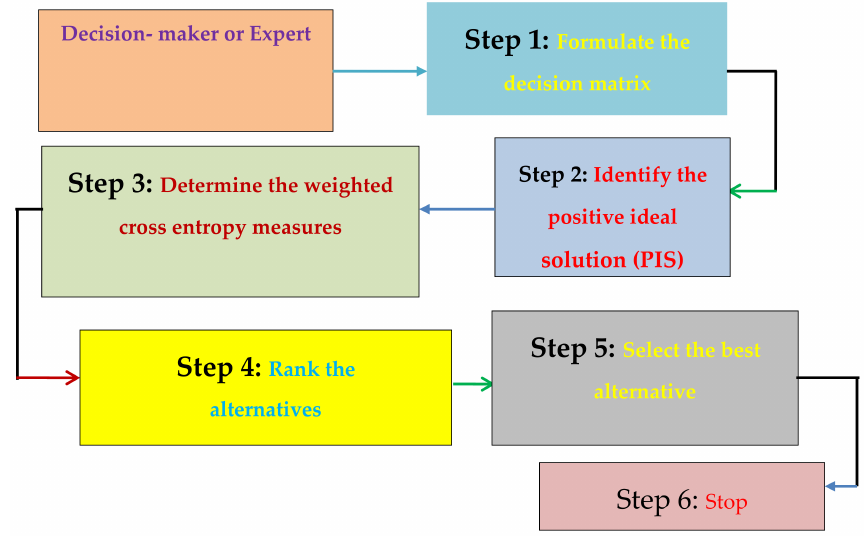
Figure 1. Conceptual model of the proposed